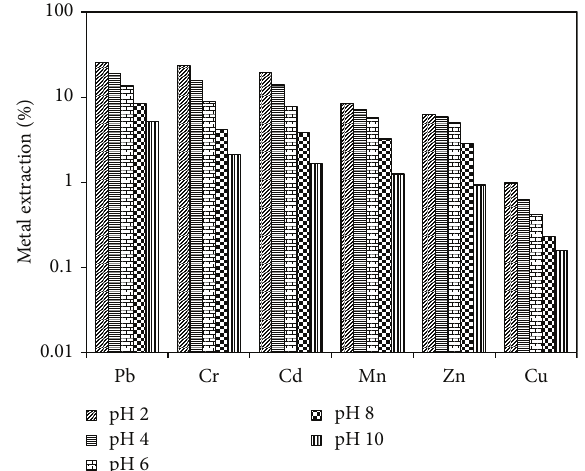
Figure 13: Leachability of metal ions at various pH conditions from